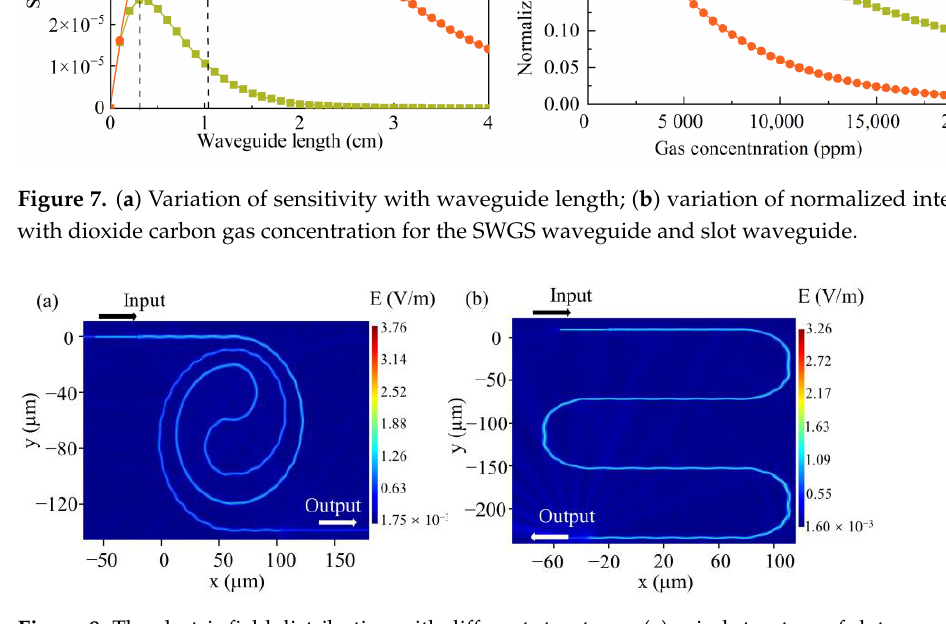
Figure 8. The electric field distribution with different structures: ( a ) spiral structure of slot waveguide; ( b ) meander structure of slot waveguide.